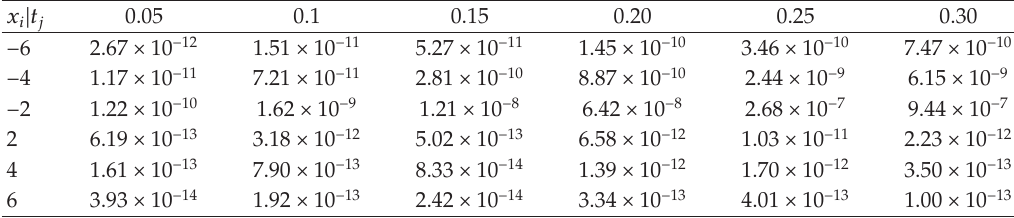
Table 2: Absolute errors regarding v (cid:2) x,t (cid:3) for system (cid:2) 1.1 (cid:3) with N (cid:8)